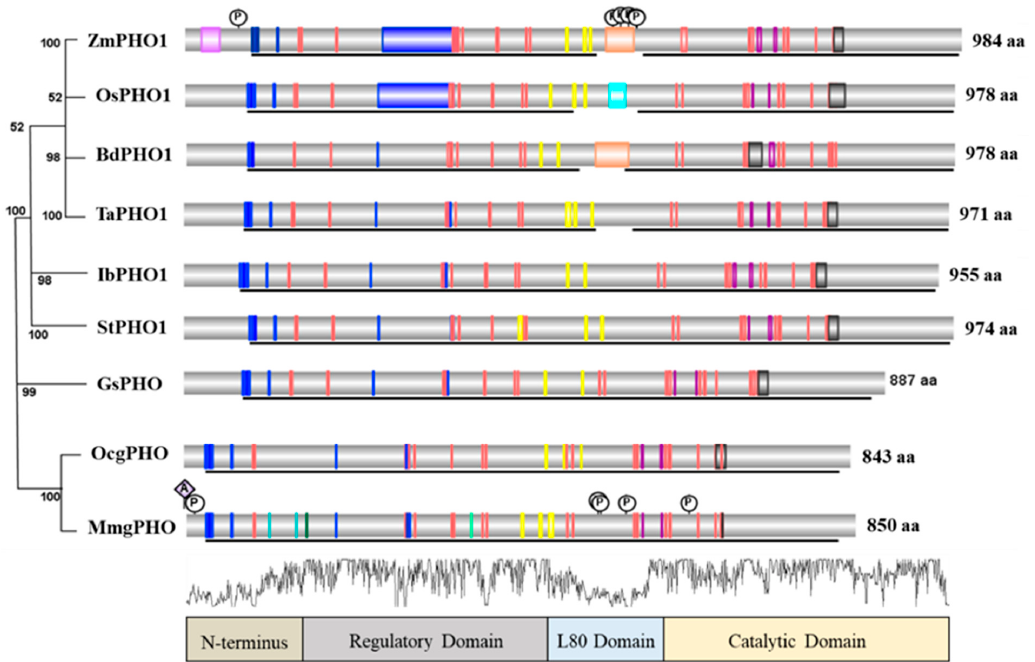
Figure 3. Annotated protein structure of phosphorylases from a wide range of species. Arranged in phylogenetic order. Representation is divided into four basic domains. Abbreviations: Zm: Zea mays , Os: Oryza sativa , Bd: Brachypodium distachyon , Ta: Triticum aestivum , Ib: Ipomoea batatas , St: Solanum tuberosum , Gs: Galdieria sulphuraria , Oc: Oryctolagus cuniculus , and Mm: Mus musculus . Amino acid numbers are varying among species. Vertical colored bars represent the different functional sites. Blue bars represent the homodimer interface for peptide binding, orange bars represent the catalytic regions, sky blue for coil entry, green for allosteric control region, gray for modification sites with pyridoxal phosphate (PLP), pink for glycine-rich domain/glutamic-acid-rich sites, yellow for glycogen storage sites, and purple for purine nucleotide inhibitor sites for caffeine. P represents the phosphorylation sites and A the acetylation sites. Brown brackets represent the PEST motif. Black lines indicate the highly conserved region that belongs to the GT35-glycogen-phosphorylase superfamily. Overall N-terminus and L80 domains are highly variable. Regulatory and catalytic domains display a high similarity index (more than 88%).